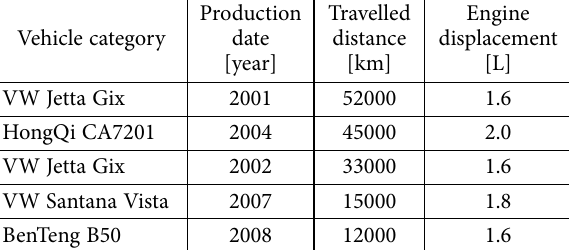
Table 1. Five types of light-duty vehicles tested Vehicle